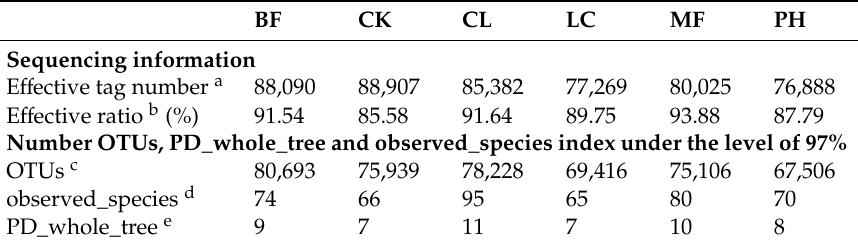
Table 1. Statistics on the data processing results.